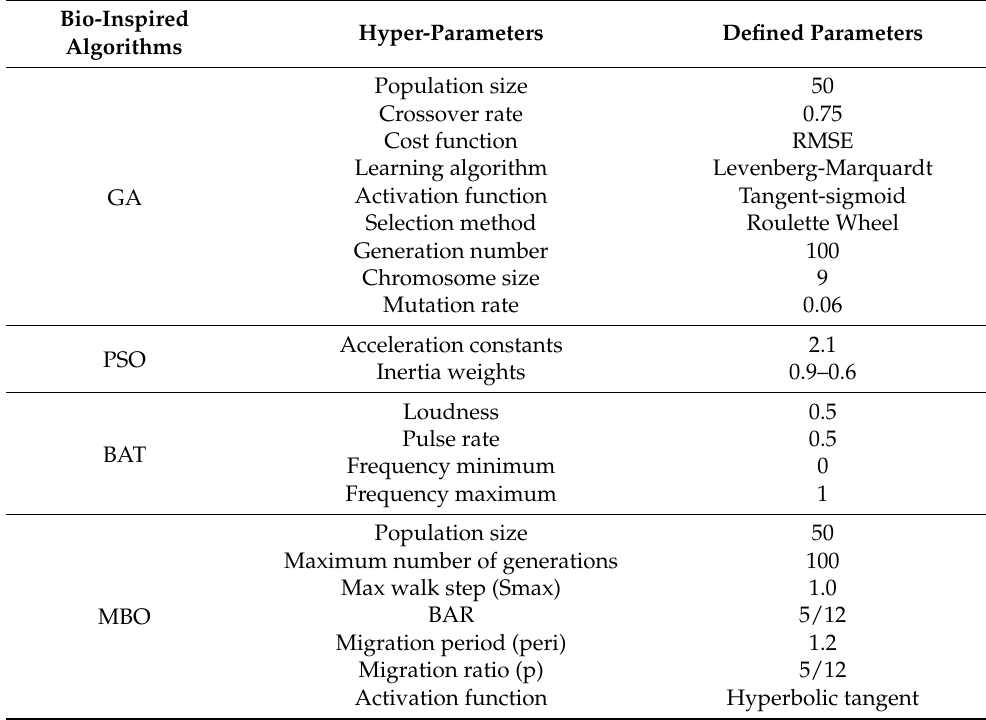
Table 1. The hyper-parameters settings of algorithms used in this